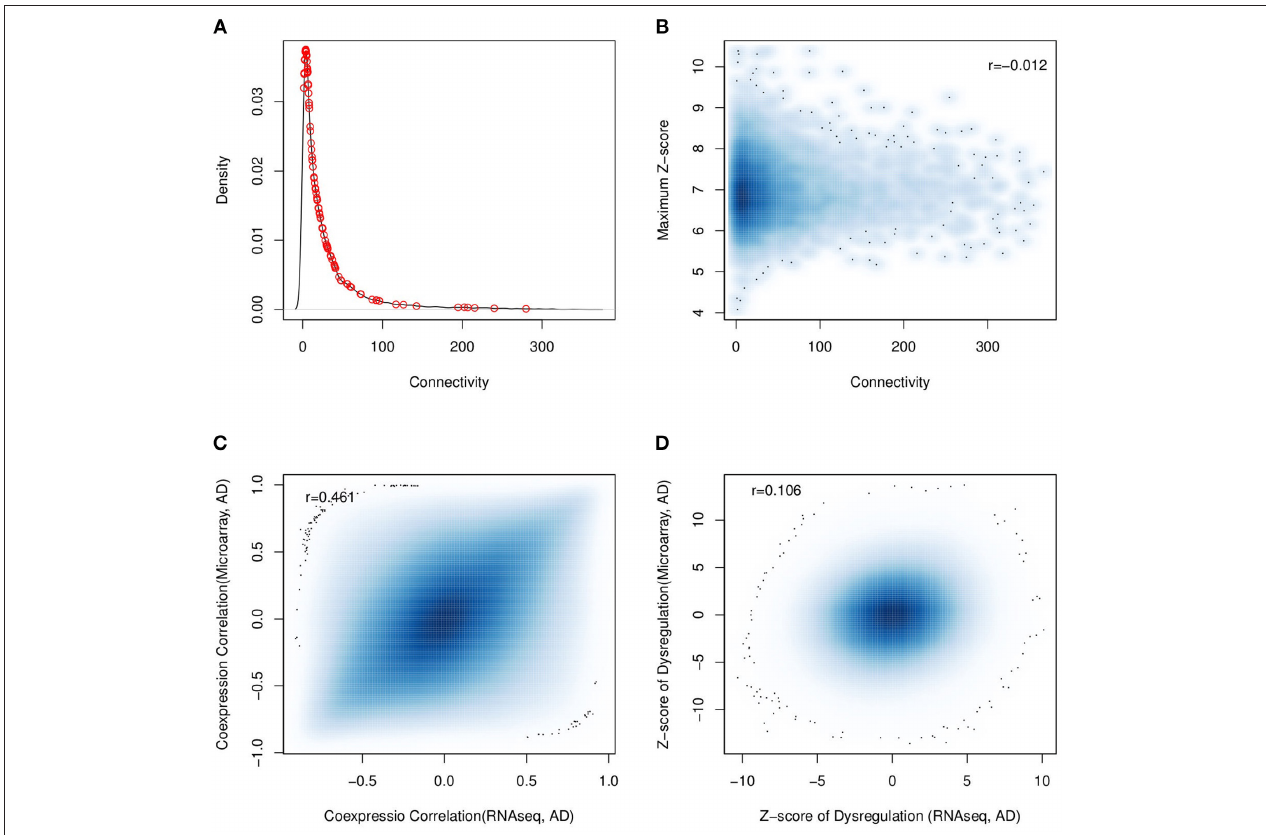
FIGURE 7 | Comparison analysis with the results from established work. (A) The connectivity distribution of top 100 of the most dysregulated genes (red circle points) fails to indicate any association between connectivity and dysregulation; (B) the same result is observed with all the genomic genes ( r = − 0.012). (C) using human RNA-seq and micorarray data, the calculated gene co-expression correlations are consistent; but (D) the predicted dysregulation are not consistent.